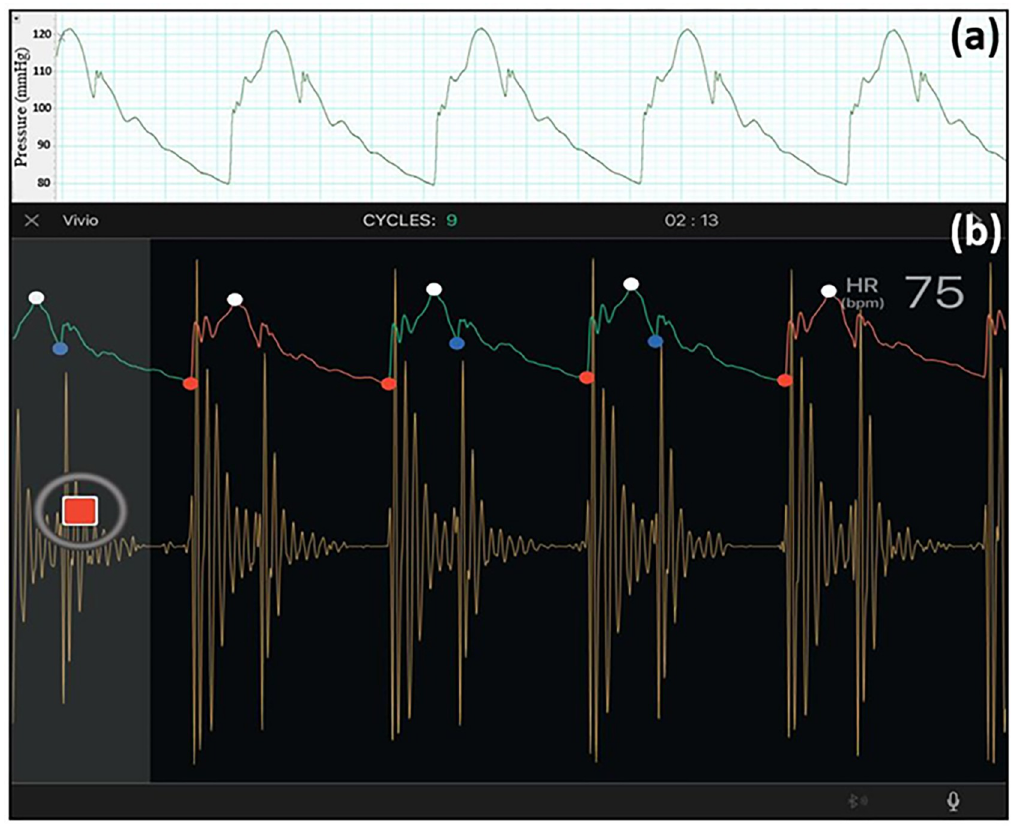
Fig 14. Example of simultaneous invasive and noninvasive measurements using (a) a Piezo-tip Millar MIKRO-TIP catheter transducer (each square accounts for 50 milliseconds), and (b) Vivio (a wireless optical tonometer [41]). Data is recorded for Aorta-4 at CO = 4.5 L/min and HR = 75 bpm. The Vivio system simultaneously measures pulse pressure and heart sound, communicating with a tablet or an iPad for real-time data display and for capturing via Bluetooth low energy